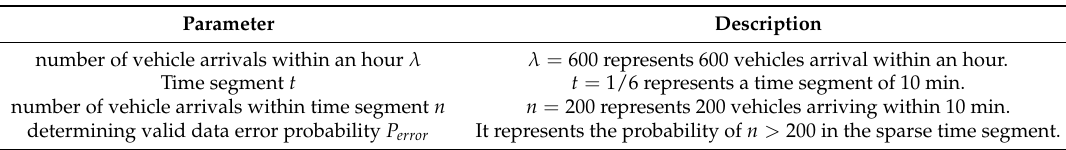
Table 1. Simulation